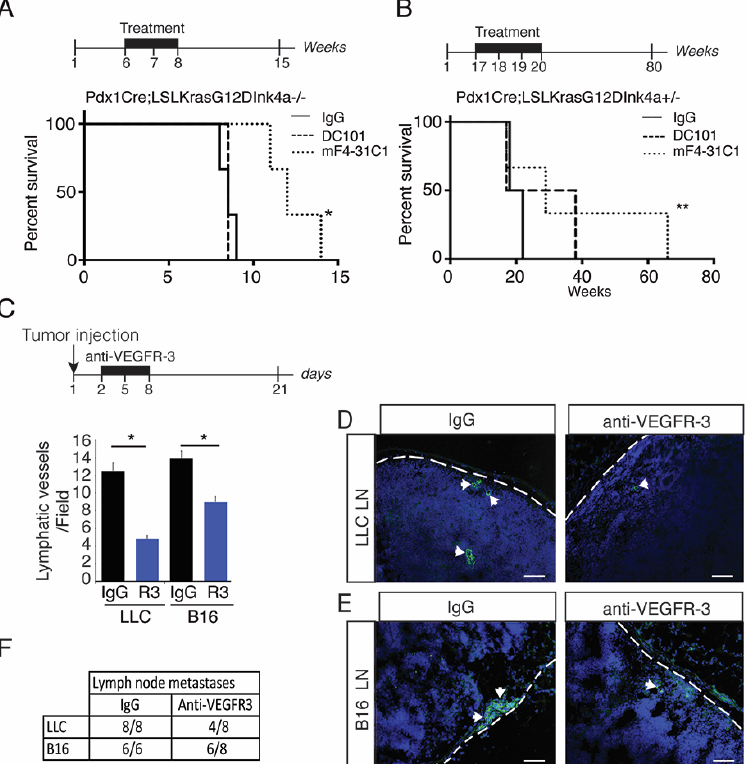
Figure 2. Blocking tumor lymphangiogenesis increases survival and reduces metastasis. ( A ) Kaplan–Meier survival curves of Pdx1Cre; LSLKrasG12DInk4a − / − mice treated with anti-VEGFR-2 (mF4- 3C1) or anti-VEGFR-3 (DC101) antibodies; * p < 0.05. ( B ), Kaplan–Meier survival curves of PKI